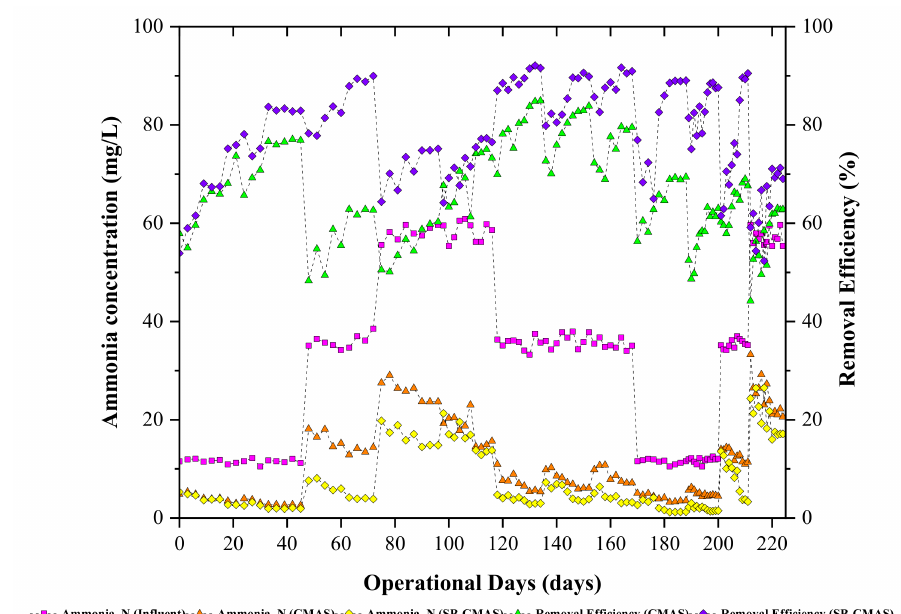
Figure 5. The CMAS and SB-CMAS bioreactor results in terms of NH 4+ -N concentrations and their removal